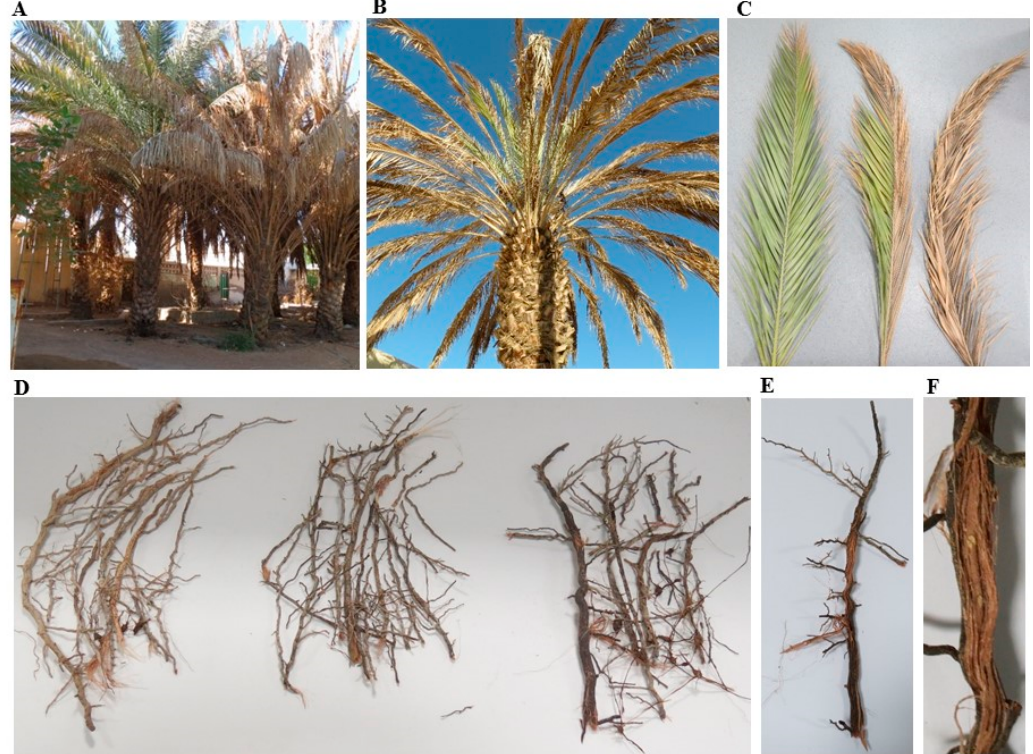
Figure 1. Date palm trees showing symptoms of sudden decline syndrome. Symptoms on a group of trees ( A ); and whole tree ( B ) of date palm. Progress of symptoms on fronds ( C ) and roots ( D ) of diseased plants. Brown-colored, dry roots ( E ); and redness of vascular tissues ( F ). In ( A – F ), naturally infested date trees with Fusarium spp.